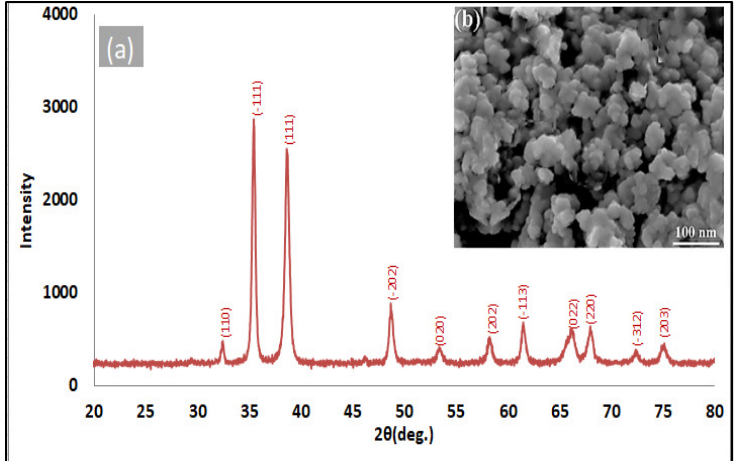
Fig. 3. XRD pattern (a) and FE-SEM (b) image of CuO